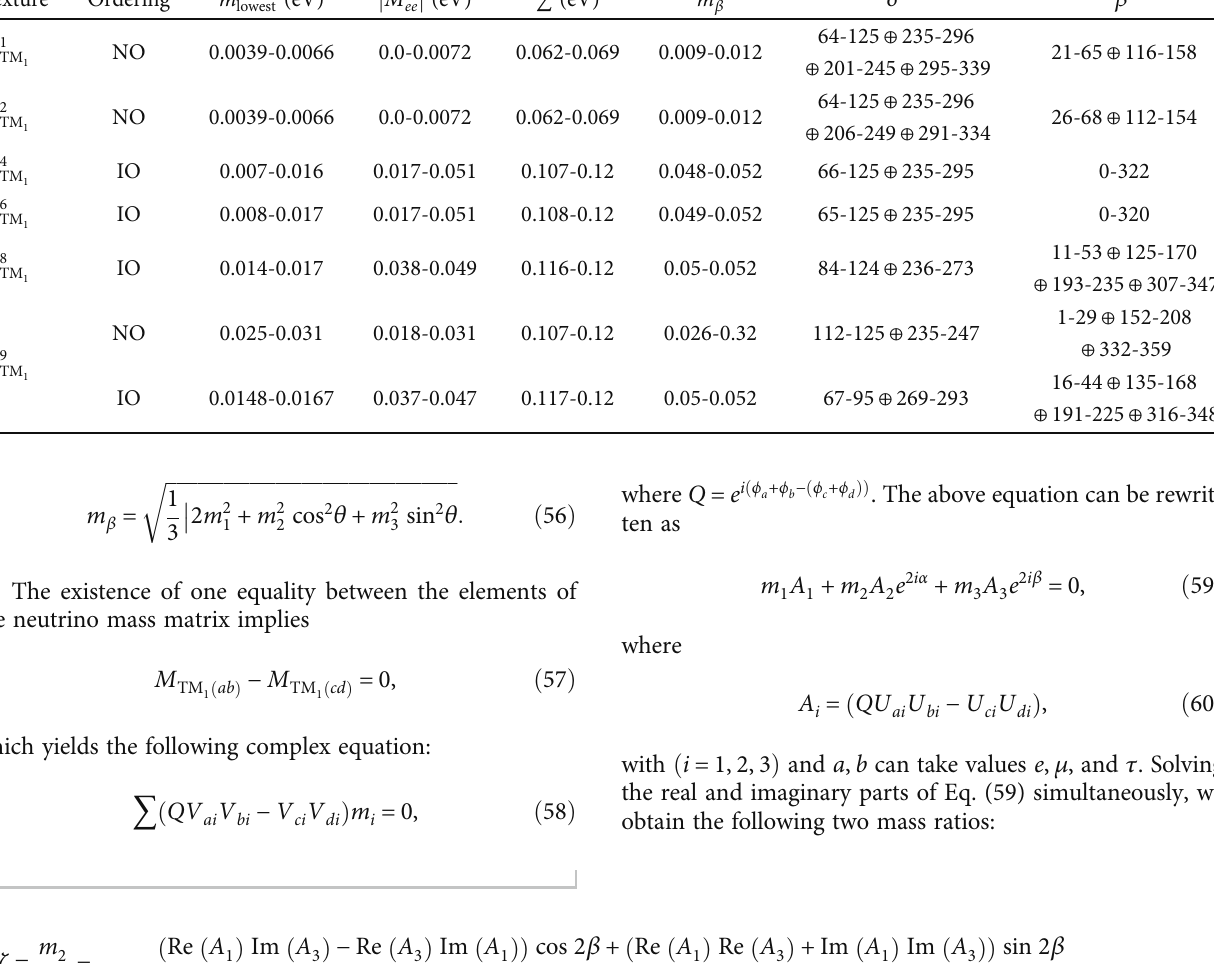
σ C.L. (cosmological and neutrinoless ν with TM 1 mixing at 3